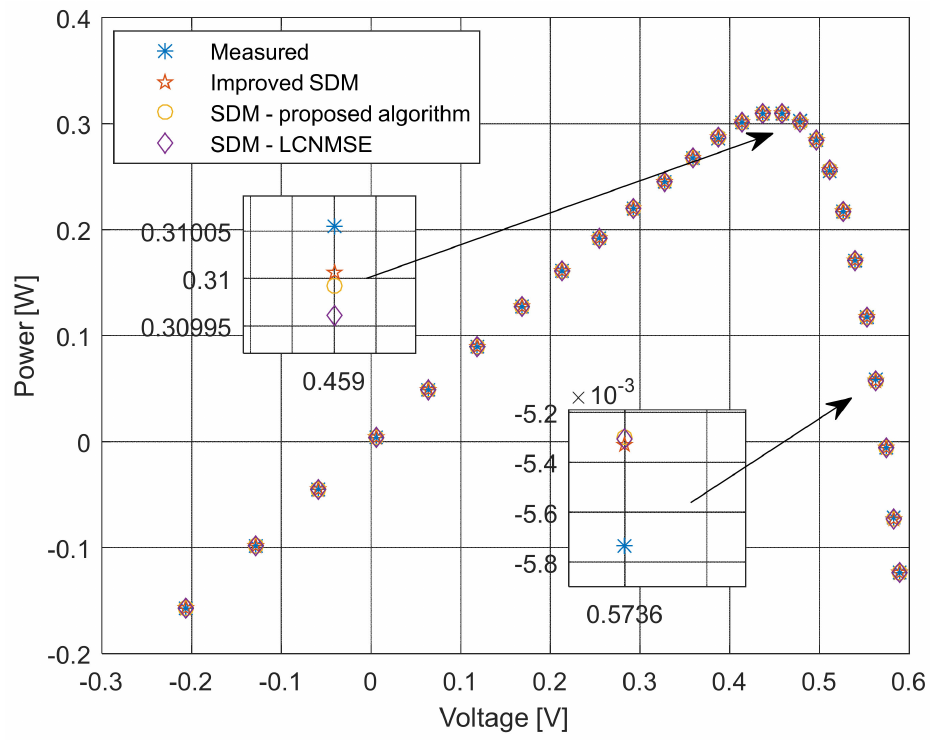
Figure 12. Power–voltage characteristics using different methods for both SDM and ISDM.